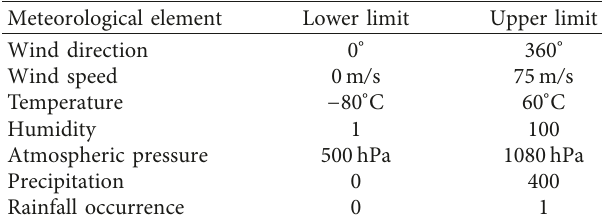
Table 2: Limits for physical limit test.